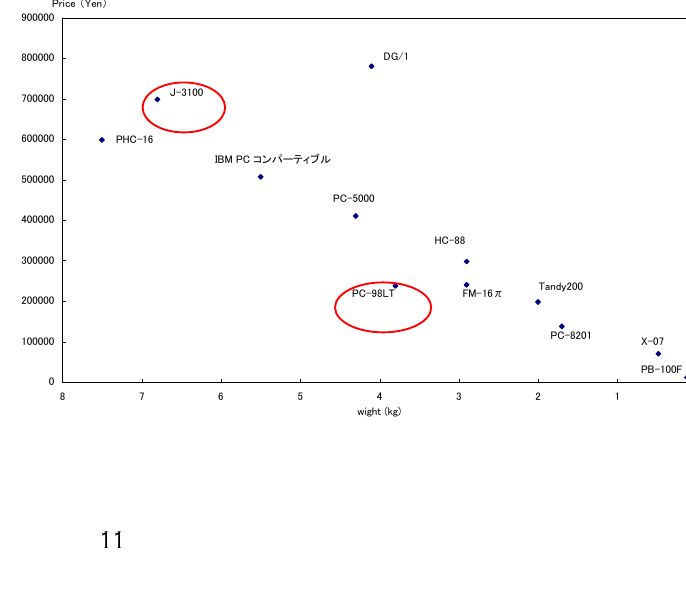
Figure 1. Appearance of various laptop